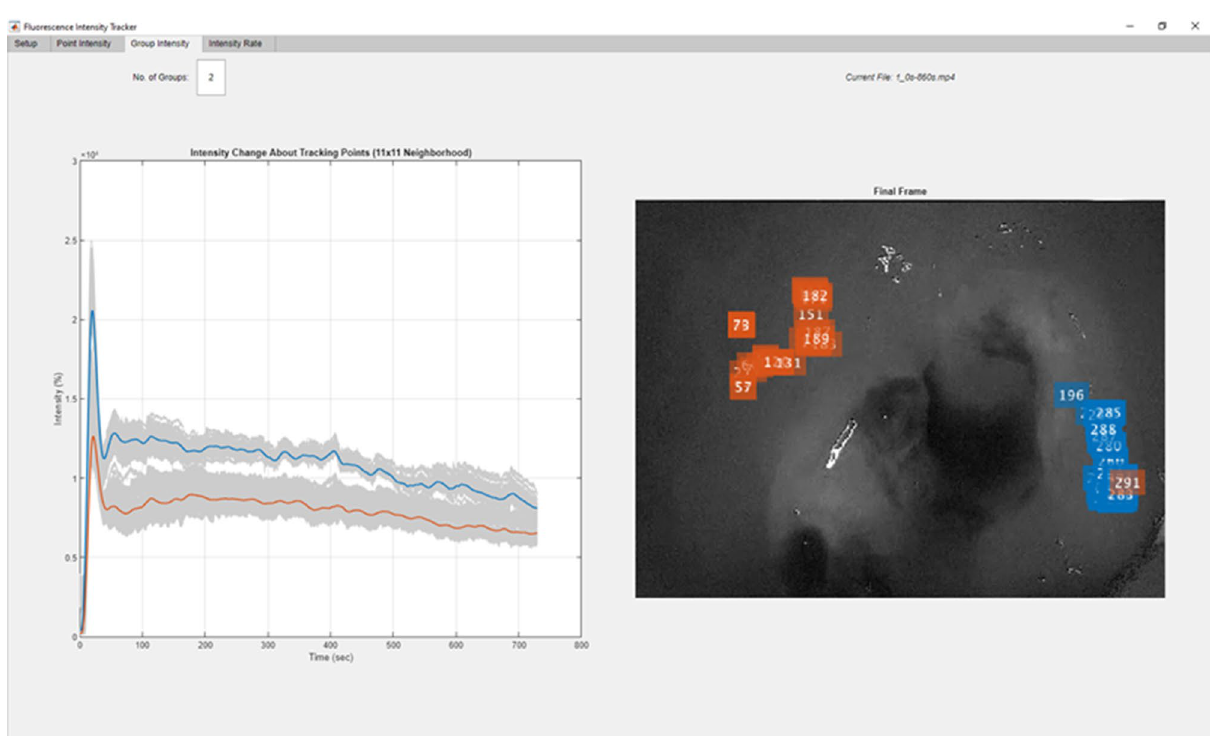
Figure 2. Screenshot of Fluorescence Tracker App (FTA, MATLAB ® ) showing post-hoc automated video-based classification of tumour (blue cluster) versus control tissue (orange cluster) once the regions of interest have been defined via initial annotation by a surgeon on the video frame corresponding to the time of fluorescence inflow. Videos are taken in vivo endorectally using the Pinpoint endoscopic NIR laparoscope while injecting 0.25 mg/kg